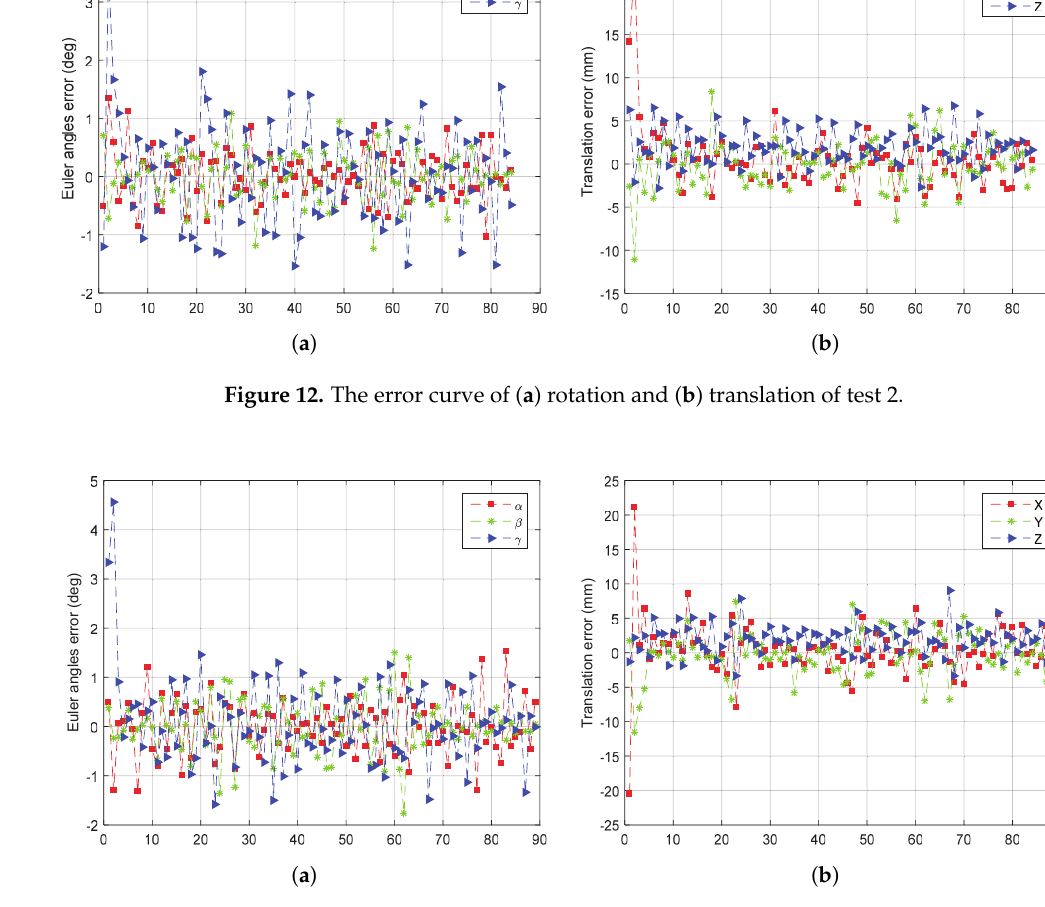
Figure 13. The error curve of ( a ) rotation and ( b ) translation of test 3.